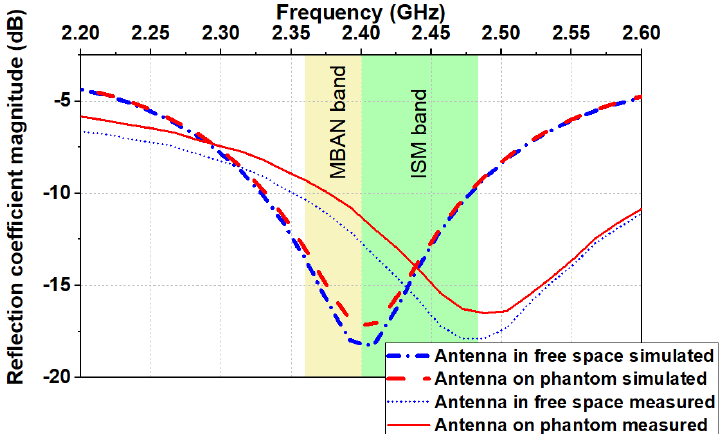
Figure 7. Simulated and measured reflection coefficient magnitudes versus frequency in the free space and on the semi-solid phantom.